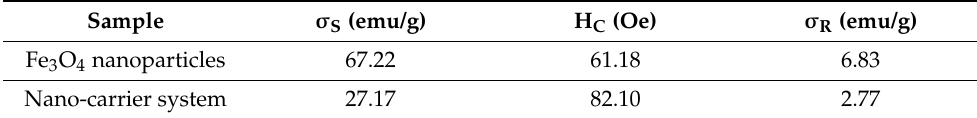
Table 4. Magnetic properties of Fe 3 O 4 nanoparticles and nano-carrier system.